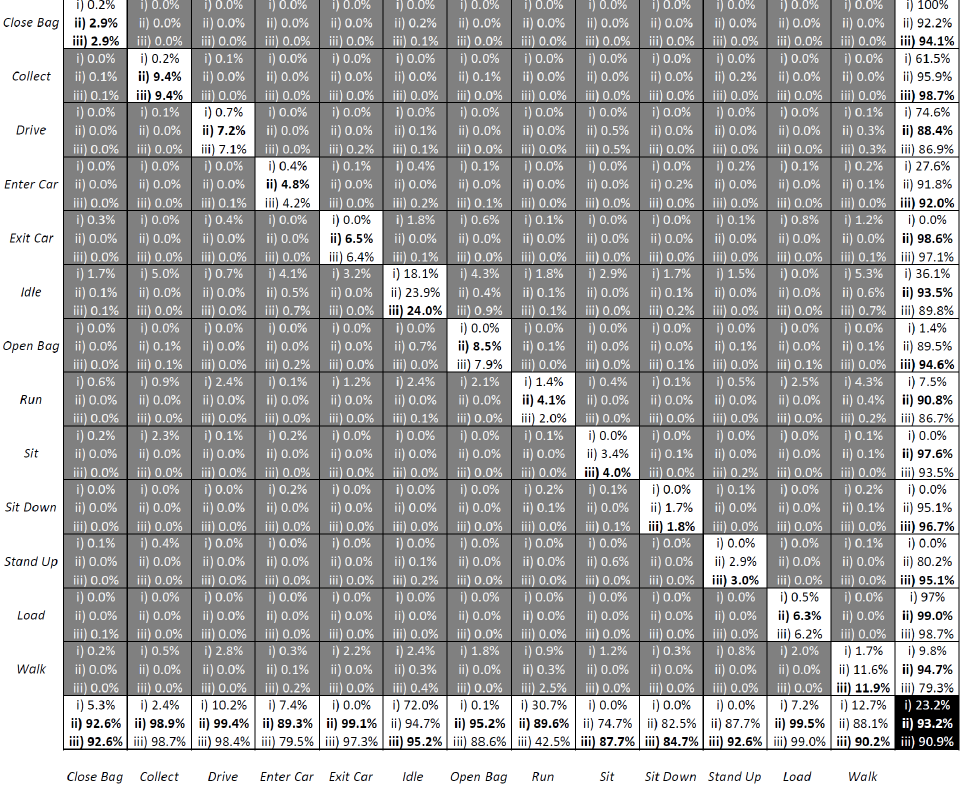
Figure 10. The confusion matrix of Traditional LSTM, Fuzzy-LSTM and FS-LSTM. Superior classifica- tion accuracy results are identified in